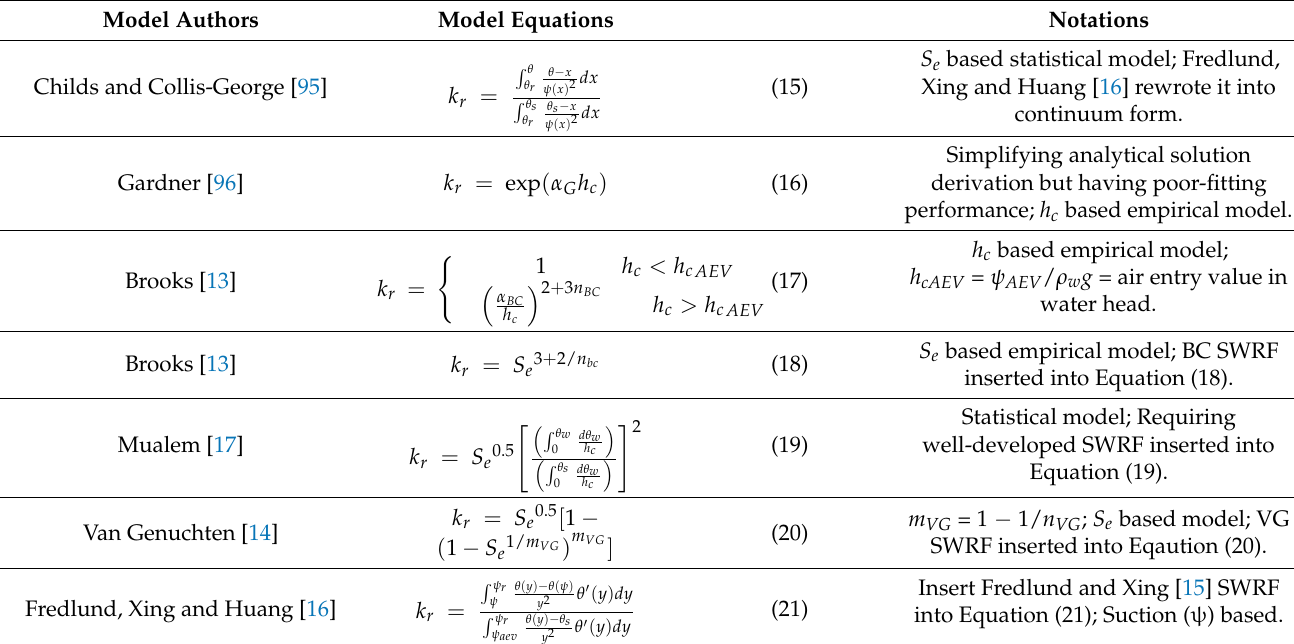
Table 3. Hydraulic Conductivity Function